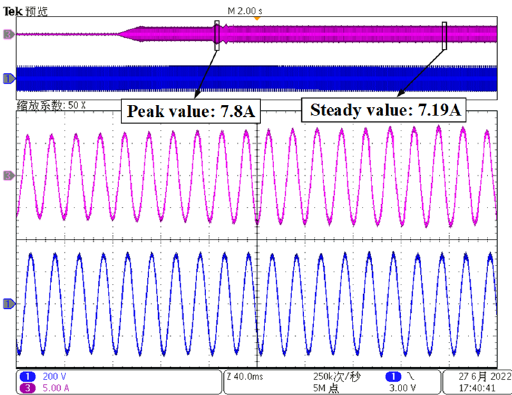
Figure 9. A waveform diagram of stator voltage and current of the DFIG-IFLVSG. The comparison results of active power and its frequency of DFIG output based on VSG control strategy and IFLVSG control strategy are shown in Figure 10. A 0 and B 0 are the maximum frequency deviation points corresponding to VSG and IFLVSG,